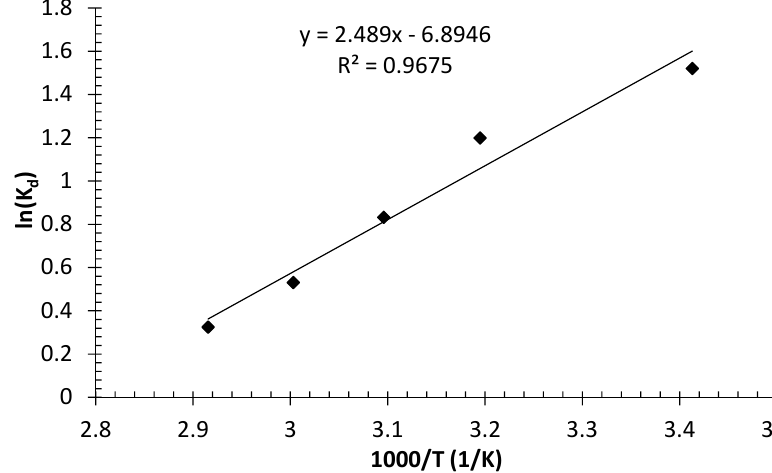
Figure 13. The van’t Hoff plot for adsorption of arsenic onto iron nanoparticles.